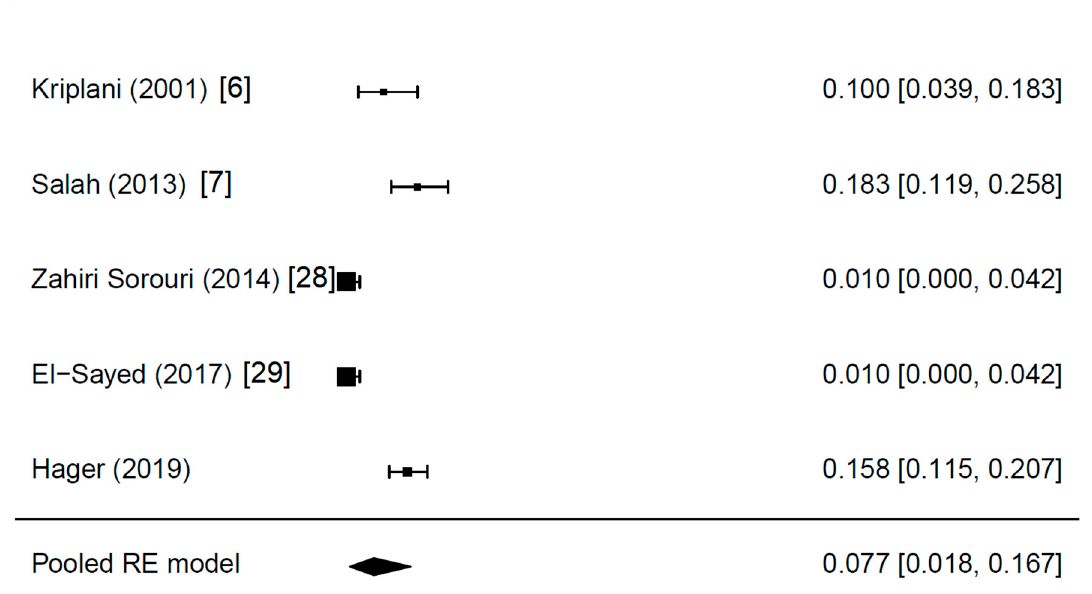
Figure 1. The prevalence of incidental endometriosis in women with CC-resistant PCOS: Results of the meta-analysis. Table 2. Estimates and 95% confidence intervals obtained in a leave-one-out sensitivity analysis. The calculations are performed as in the main analysis. However, in each round of the sensitivity analysis one study is not included.